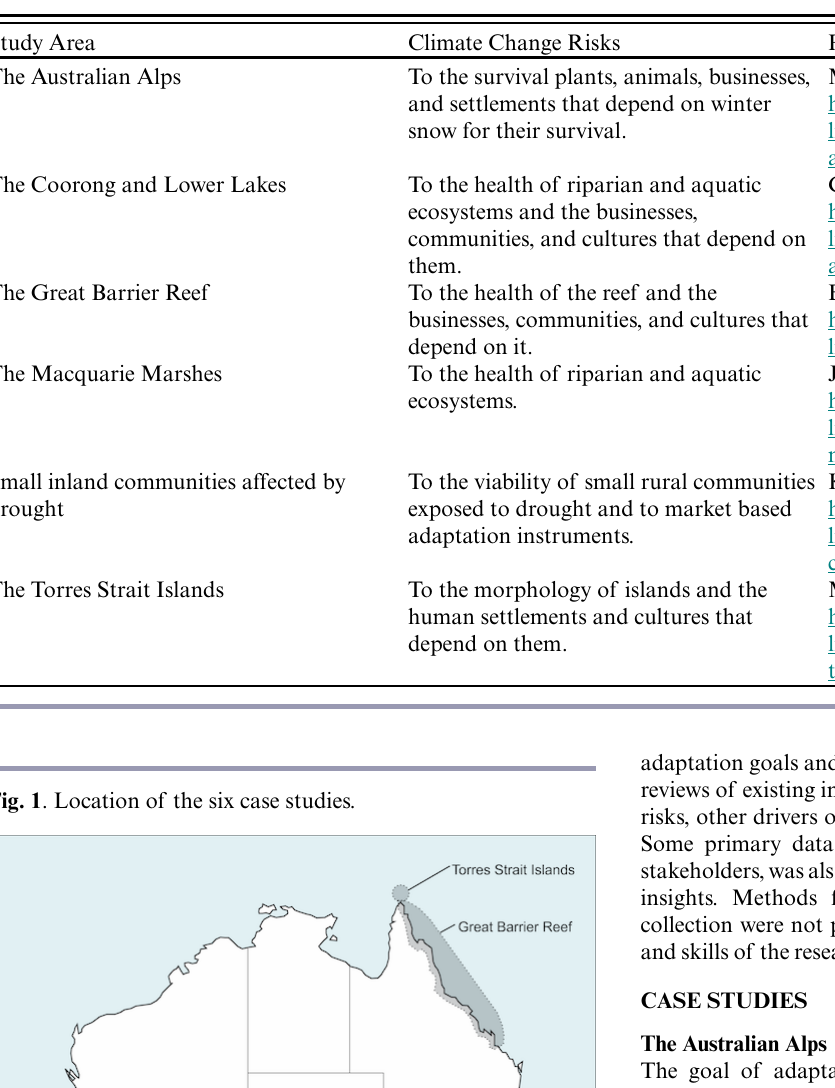
Table 1 . The six case studies.